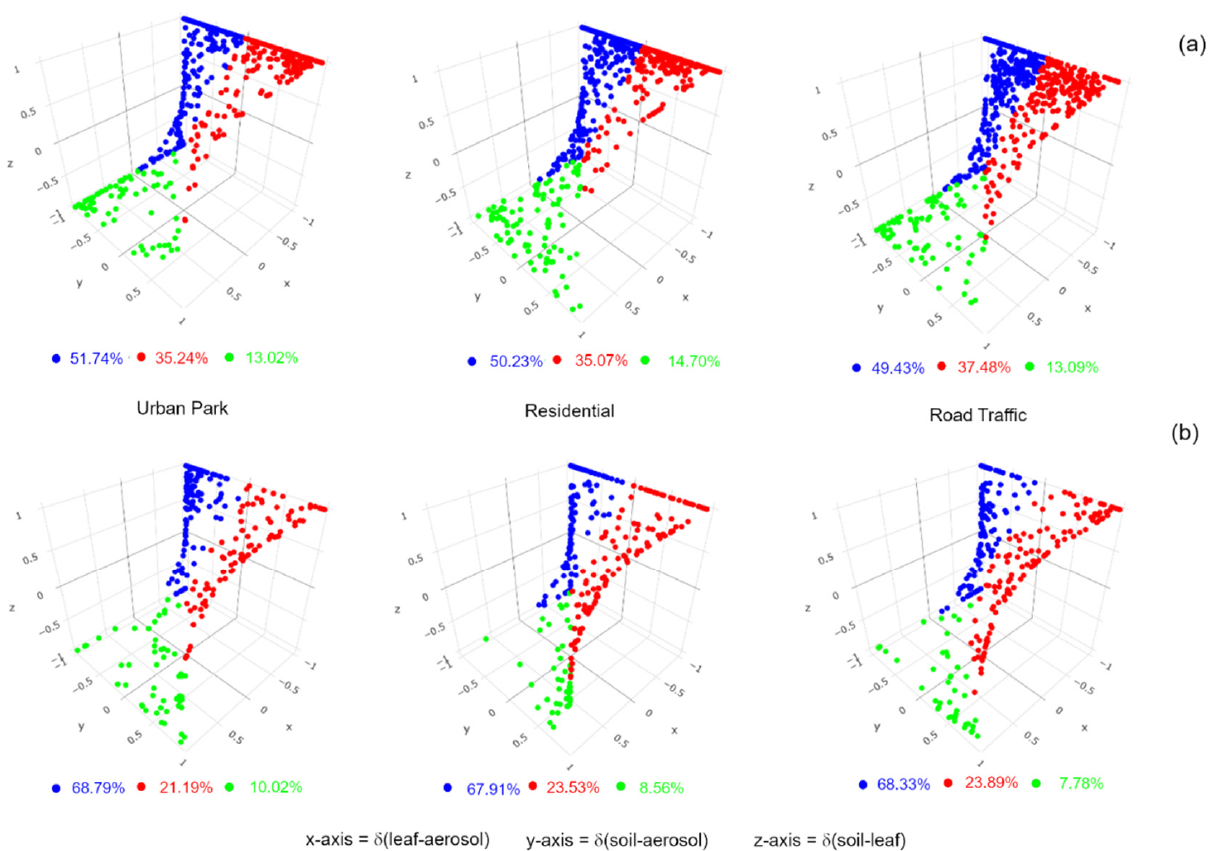
Figure 5. The reconstruction of source-sink relationships of aerosol (PM 10 )-associated microbial communities with microbes of Q. ilex leaf surface and road dust detected in the Urban Park, Residential and Road Traffic sites of Rome. Prevalence of each bacterial ( a ) and fungal ( b ) OTU in the airborne PM 10 (blue dot), road dust (red dot), and leaf surface (green dot) was displayed by plotting the normalized-differences in the proportional abundances between leaf and aerosol samples δ (leaf-aerosol), between road dust and aerosol samples δ (soil-aerosol), and between road dust and leaf samples δ (soil-leaf) on the x, y and z axes, respectively. All OTUs at species-level detected in the aerosol (PM 10 )-associated microbial communities were included in each analysis.